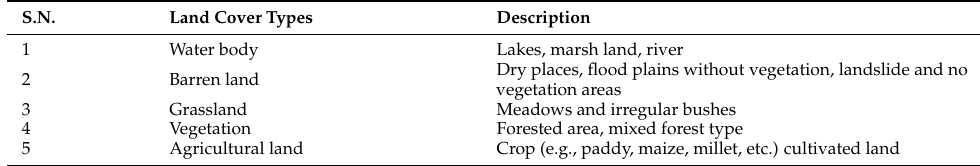
Table 2. Major land use and land cover types classified in the